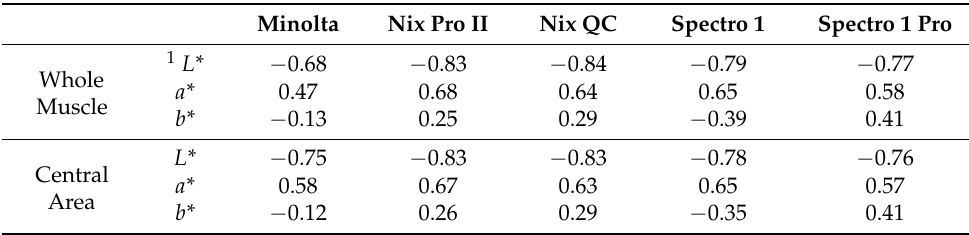
Table 6. Correlation coefficients of instrumental measurement with Japanese pork colour standard on fresh pork colour. Minolta Nix Pro II Nix QC Spectro 1 Spectro 1